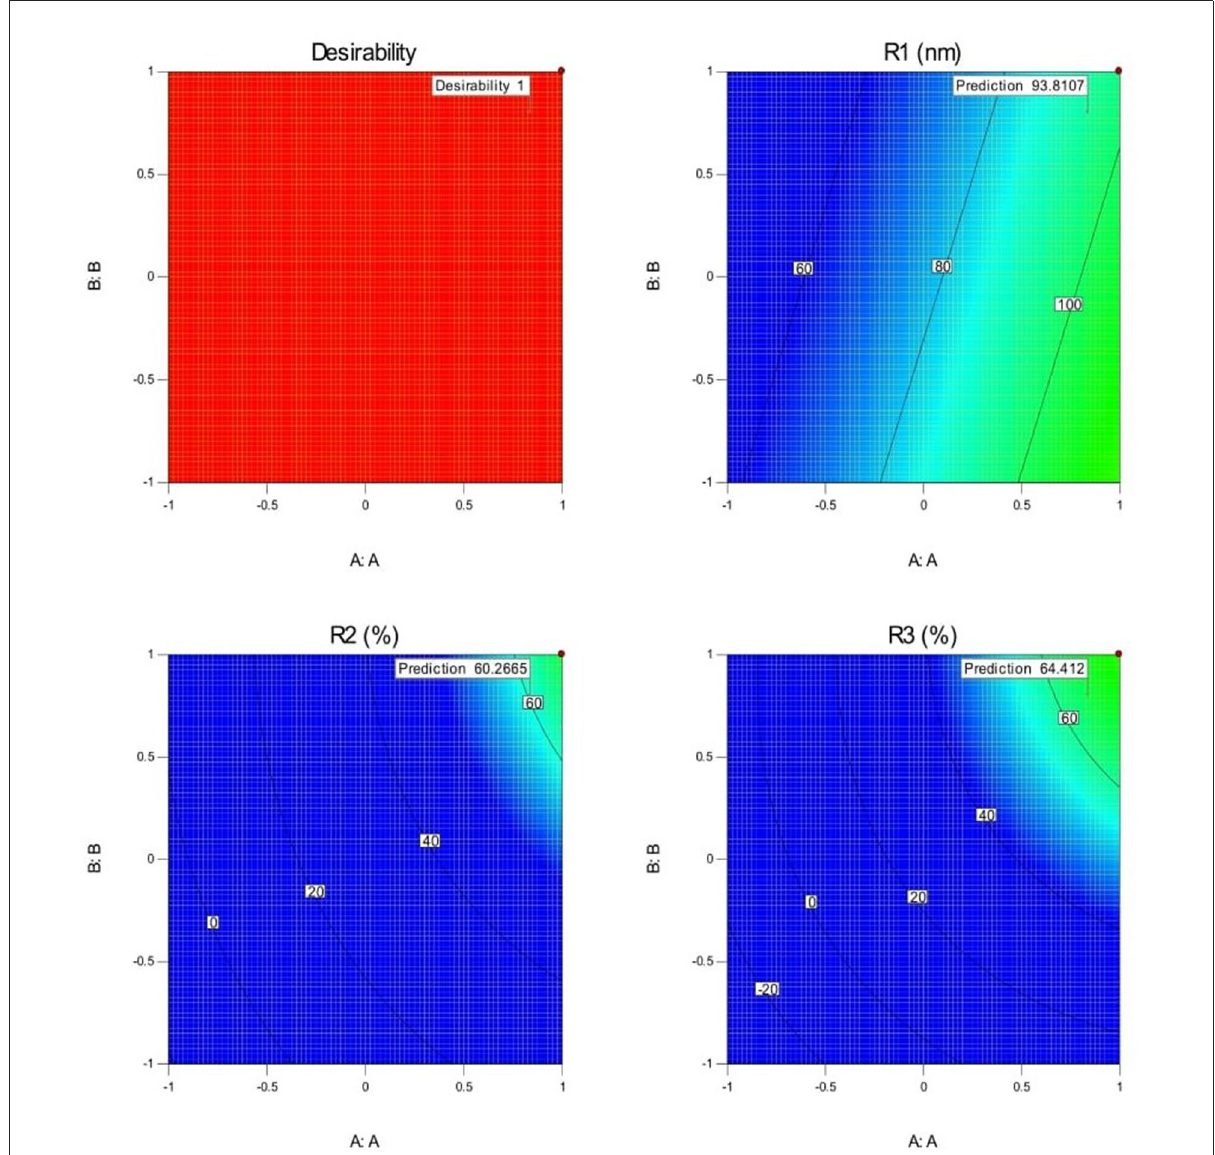
FIGURE4 Desirability index for dependent